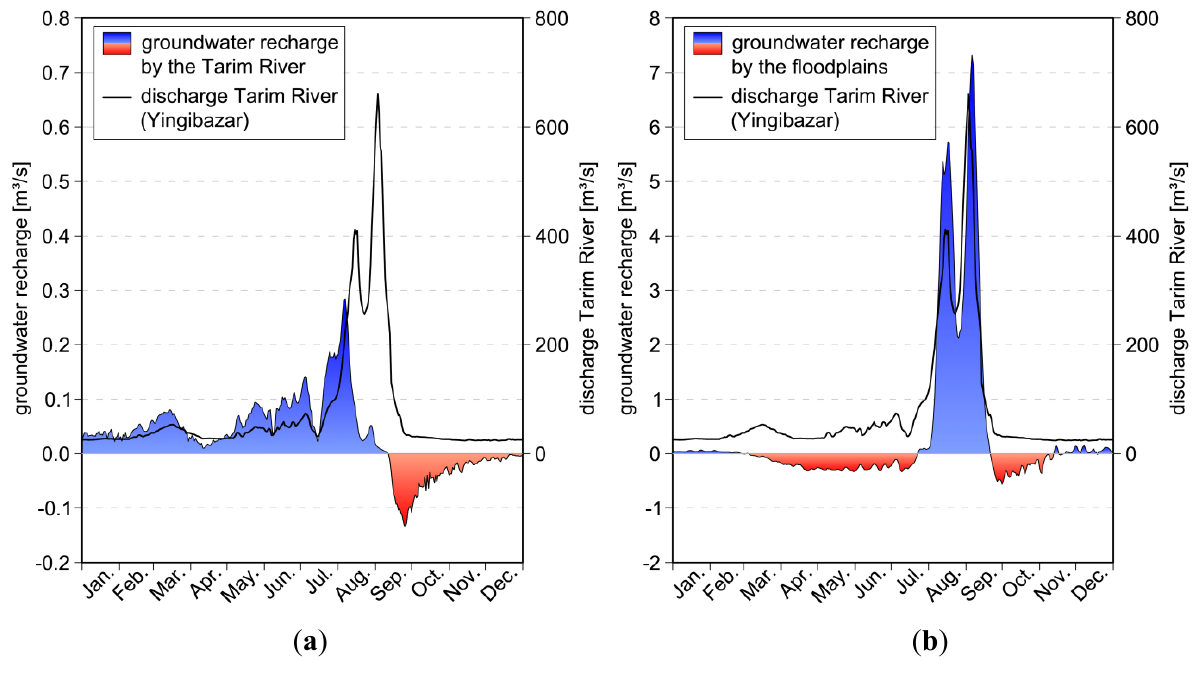
Figure 4. Groundwater recharge by the Tarim River ( a ) and floodplains ( b ) for the year